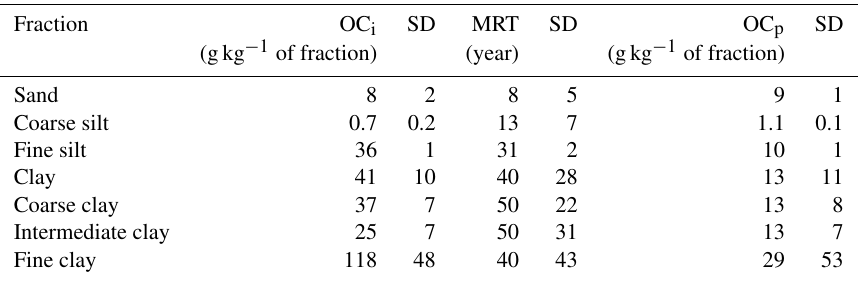
t MRT + OC p ) used to fit the evolution of organic carbon content